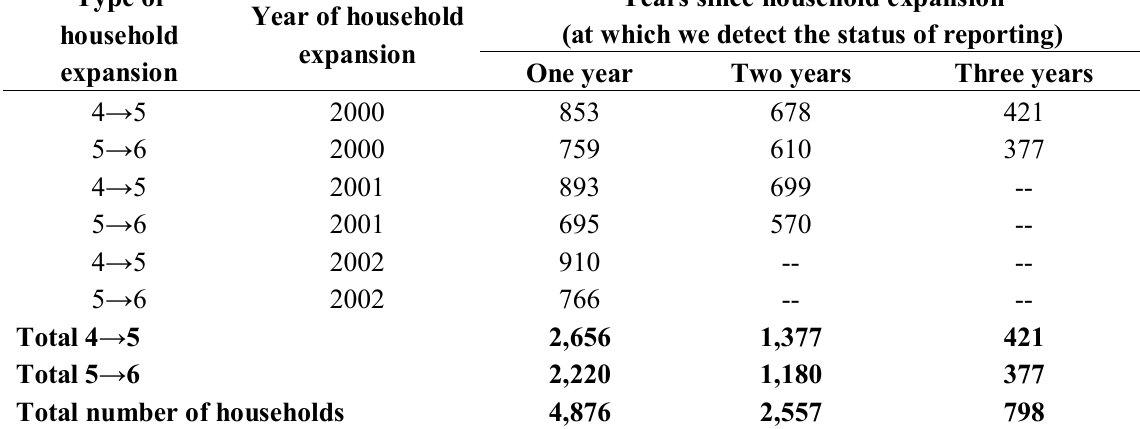
Table 6. The working datasets—number of households by reporting status and household